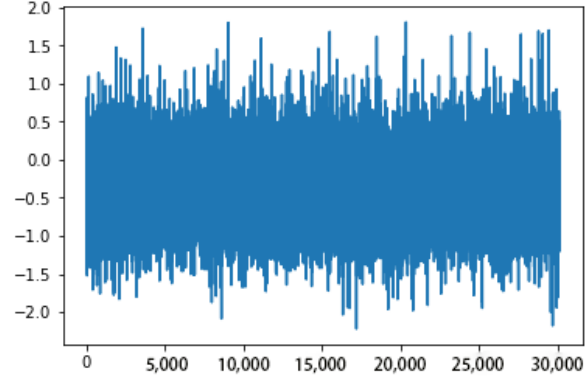
Figure 10. Partial estimation error after